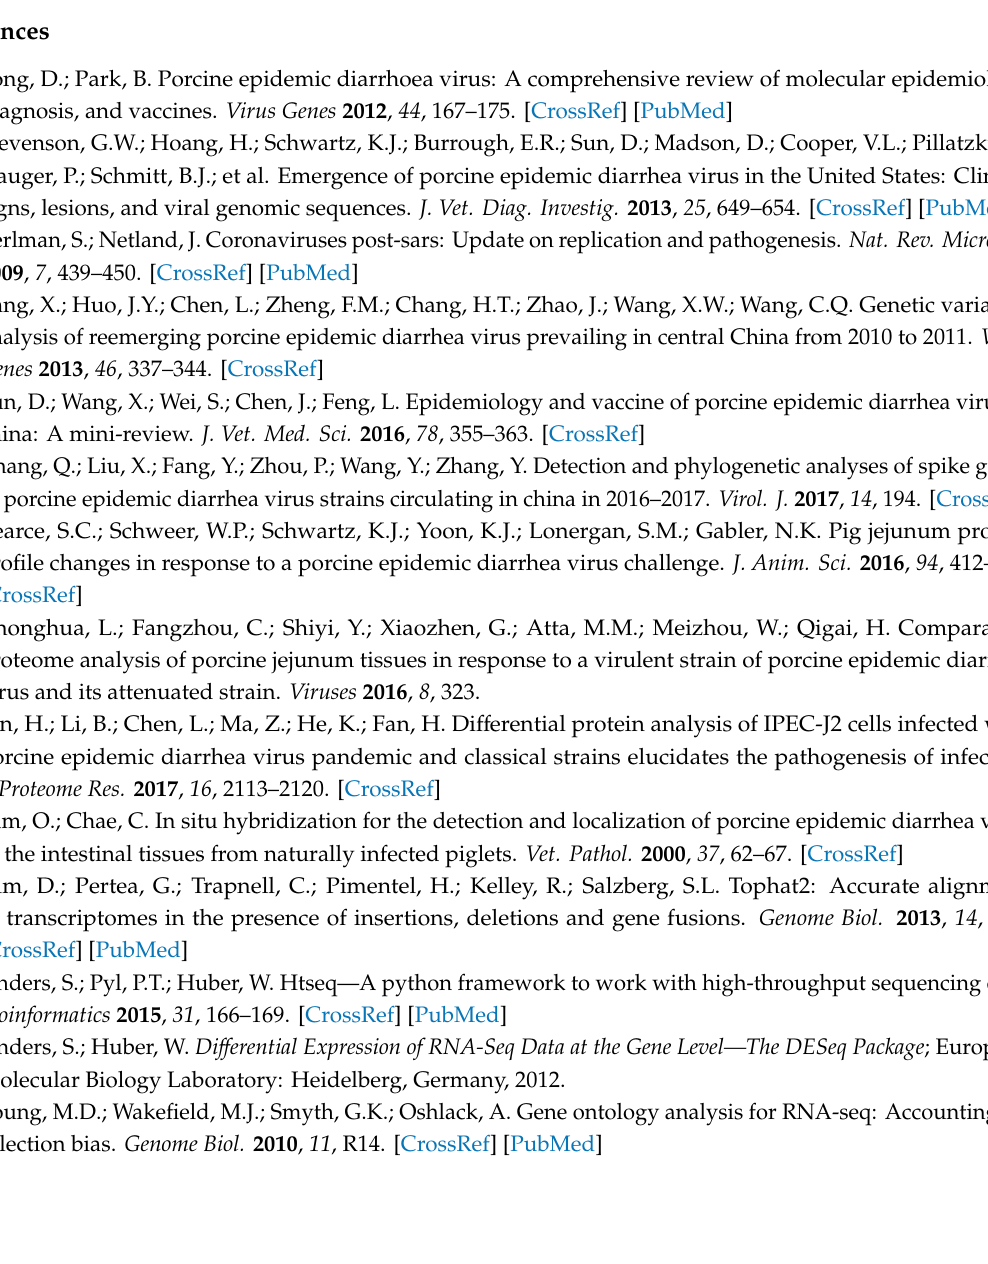
Table S1: Primer sequences used for qRT-PCR, Table S2: Statistics for RNA-seq data of all samples, Table S3: Summary of RNA-seq mapping results, Table S4: Di ff erentially expressed genes between PEDV-infected and control groups, Table S5: List of genes in di ff erent gene clusters, Table S6: Gene Ontology analyses for di ff erentially expressed genes, Table S7: Pathway analyses for di ff erentially expressed genes, Table S8: The full set of significant motif occurrences, Table S9: List of gene associated with H3K4me3 enrichment, Table S10: Gene Ontology analyses for genes associated with H3K4me3 modifications, Figure S1: Amplification of PEDV M gene and PCR sequencing, Figure S2: Percent of reads mapped to the genomic regions, Figure S3: Pearson correlation coe ffi cients between the samples within each group, Figure S4: Clusters of the di ff erential expression genes by K-means clustering